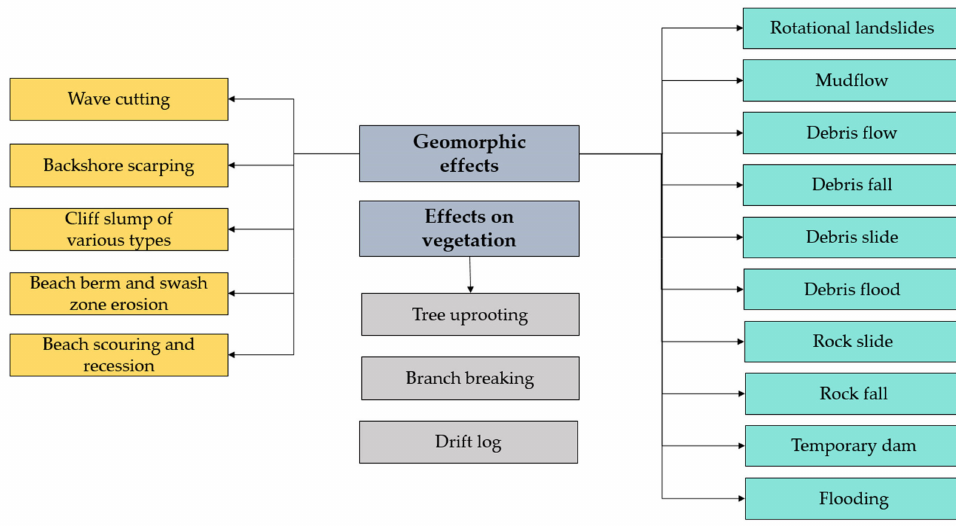
Figure 6. Types of impacts of Ianos Medicane on the natural environment, including geomorphic effects and